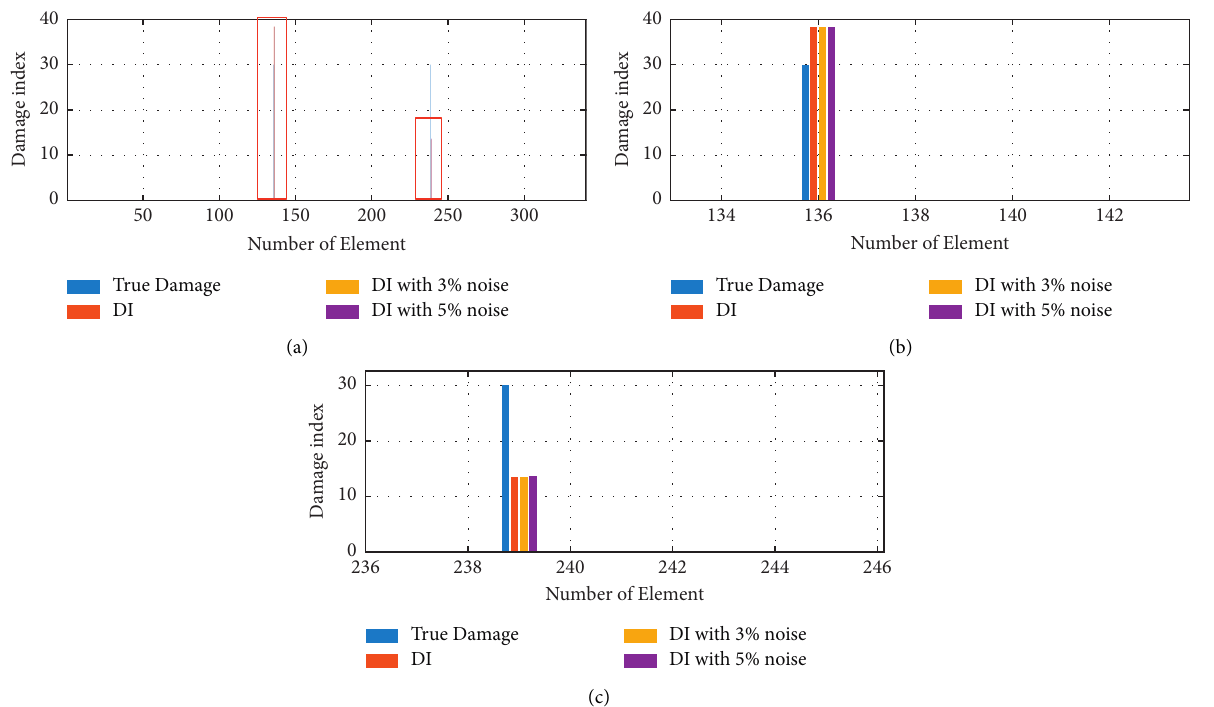
Figure 14: Results of multiple-damage scenario D3 containing measurement noise. (a) Original result. (b) Zoomed result part 1. (c) Zoomed result part